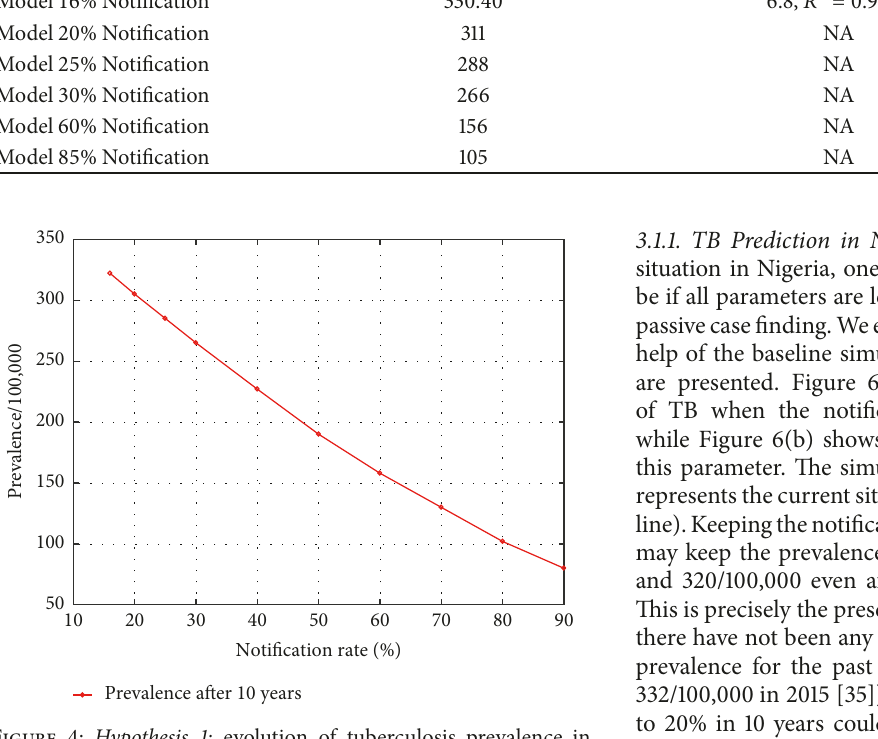
Figure 4: Hypothesis 1: evolution of tuberculosis prevalence in Nigeria after 10 years of simulation with different notification rate. Each point on the curve shows the prevalence of tuberculosis in Nigeria when simulated with the corresponding notification value on the x-axis for 10